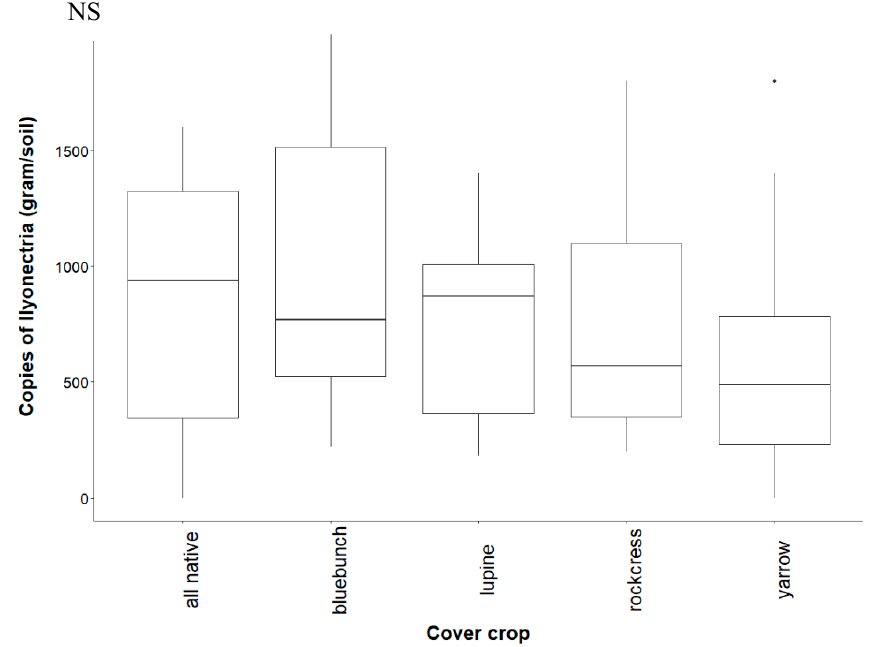
Figure A3. Recovery of I. liriodendri DNA from soil after conditioning with native cover crops. Treatments are all plants grown together (“all native”), bluebunch wheatgrass (“bluebunch”), silky lupine (“lupine”), Holboell’s rockcress (“rockcress”), and white yarrow (“yarrow”). Copy number did not differ significantly (NS) among treatments ( p = 0.731).